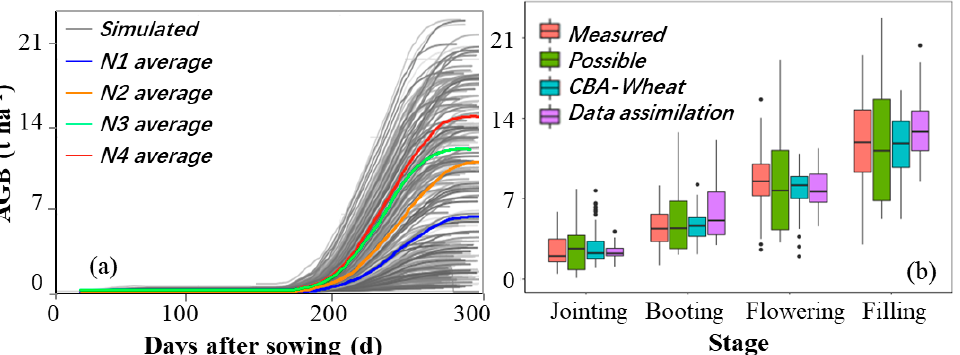
Figure 4. Winter AGB distribution in different stages. ( a ) the measured and the simulated AGB in four different stages. ( b ) the AGB distribution in the measured dataset, the possible dataset from the SAFY model (Section 2.3.3), CBA-wheat dataset and data assimilation of the four growth phases. 3.2. AGB Distribution for Different Datasets in Different Stages The predicted AGB values were compared to 384 destructive measured AGB during four growth phases. The comparison between the measured AGB and the predicted AGB using CBA-Wheat (Figure 5) reveals a good correlation with R 2 of 0.83 and RMSE of 1.91 t ha − 1 . CBA-Wheat and data assimilation have similar AGB estimation accuracy at different growth stages, which provides a solid foundation for the transfer learning method to replace the crop growth model for yield estimation.